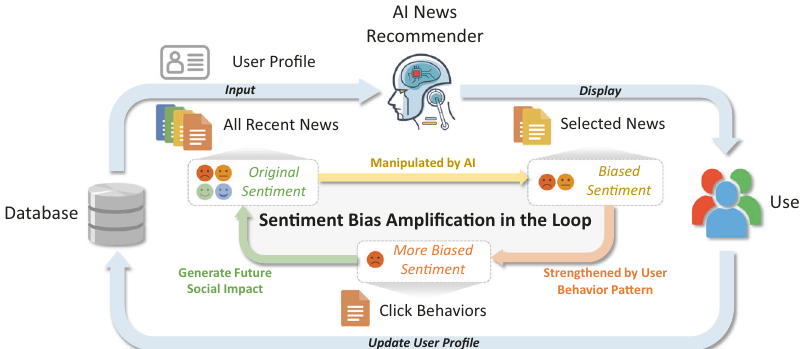
Fig. 1 The ampli fi cation of sentiment bias in the loop of human-AI interactions. The AI news recommender selects a few news articles from the full set of recent news according to users ’ personal interests inferred from the user pro fi le. Users interact with the selected news displayed to them, and their behaviors such as clicks are used to update the user pro fi le in the database. In this loop, since users have biased preferences for negative news sentiment, the recommendation AI learned on user data can inherit and amplify the sentiment bias, which leads to AI ’ s manipulation of the sentiment of selected news. Users ’ further biased behaviors can strengthen the sentiment bias, and such highly biased sentiment orientation evoked by a large number of users can generate future social impacts and in fl uence the overall sentiment of future news. The dilemma of sentiment bias ampli fi cation in the loop can make AI heavily control the sentiment of news displayed to